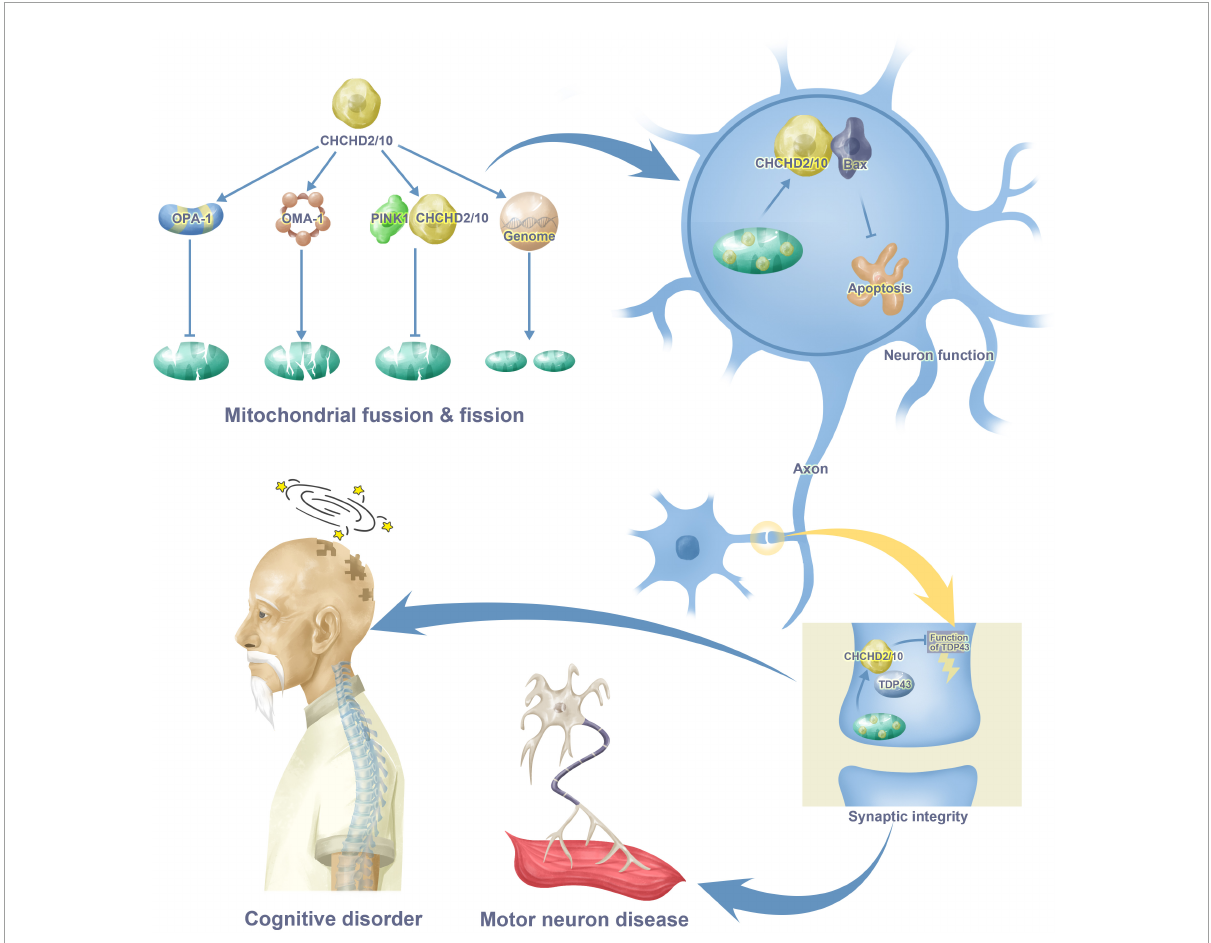
FIGURE1 CHCHD2 and CHCHD10 functions in cognitive disorder and motor neuron disease. CHCHD2 and CHCHD10 play a role in mitochondria through mitochondrial fusion, fission and gene synthesis. CHCHD2 and CHCHD10 in mitochondria enter the cytoplasm of neurons through the combination with Bax, resulting in apoptosis. Moreover, CHCHD2 and CHCHD10 also appears in synaptic, binding to TDP43, inhibiting TDP43 neurotoxicity as a result. All these maladjustment contribute to cognitive disorder and motor neuron